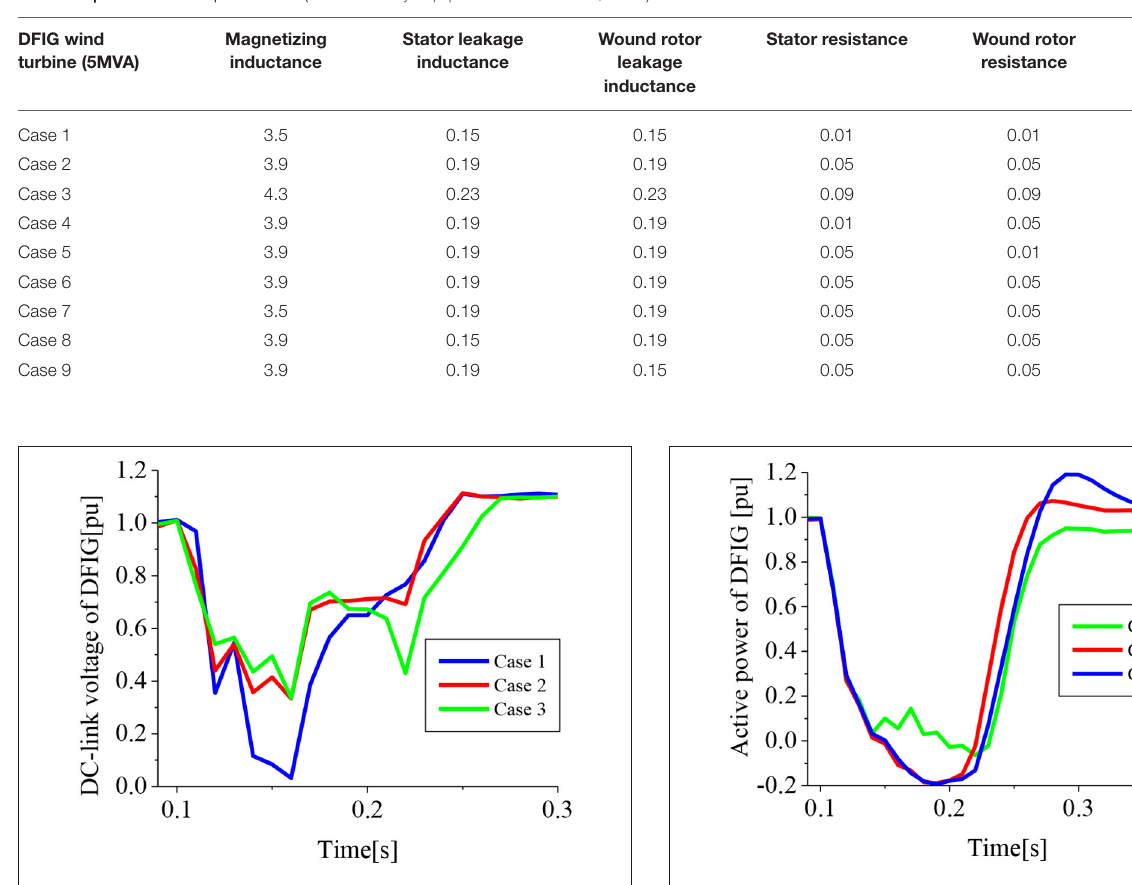
FIGURE 7 | DC-link voltage of DFIG (cases 1–3). FIGURE 8 | Active power of DFIG (cases 1–3).